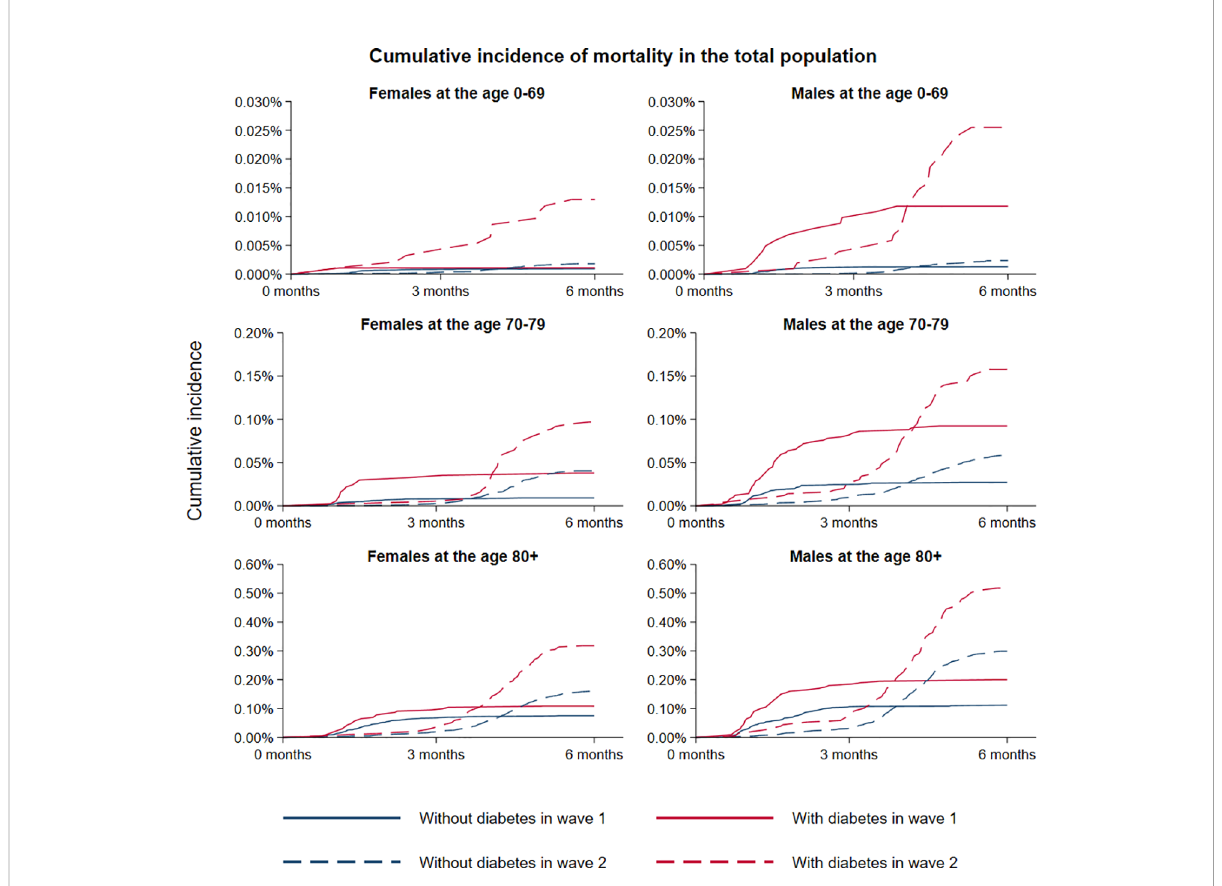
FIGURE 1 Crude mortality rates according to diabetes status during the fi rst and second wave of COVID-19 in Denmark. Strati fi cation were made according to females and males, and age 0-69, 70-79 and 80+ years, respectively. Time was de fi ned according to the start date of the two